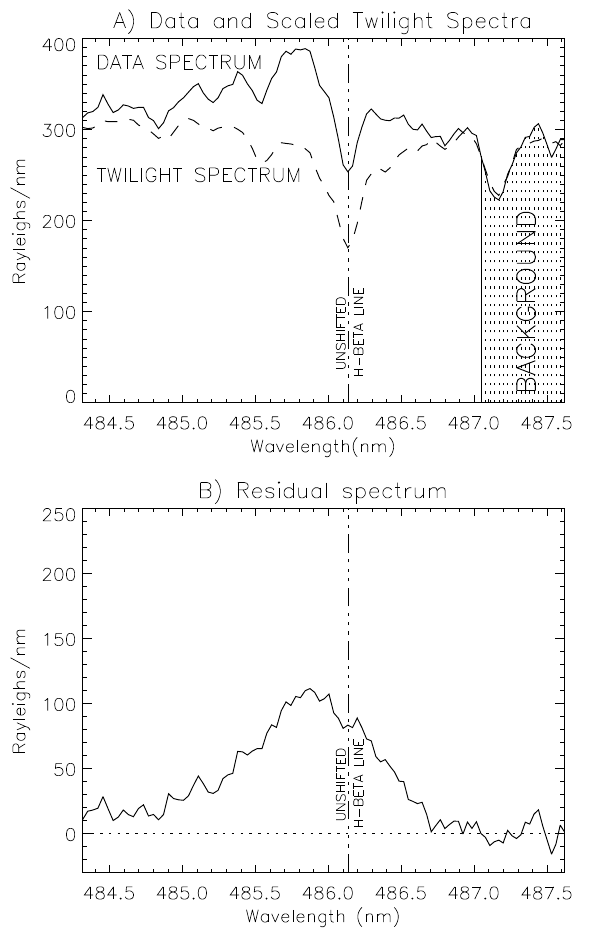
Fig. 4. (A) A measured spectrum (solid line), integrated for 60s beginning at 09:06:34 on 27 November, 2000. The φ -scaled twi- light spectrum is drawn as a dashed line. (B) The residual spectrum after the scaled twilight spectrum has been subtracted from the data spectrum.